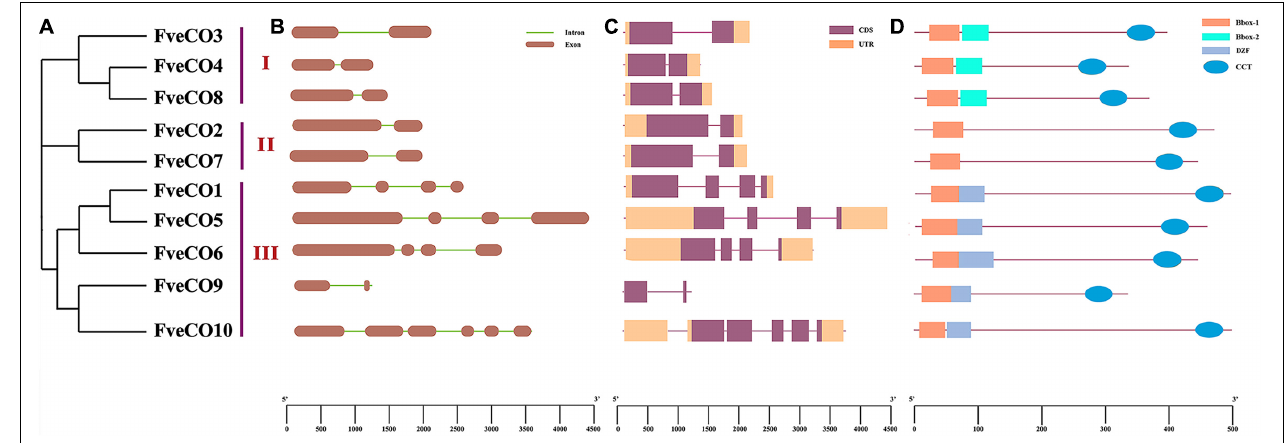
FIGURE 3 | Genomic and protein structures of FveCOs . (A) Phylogenetic analysis of 10 FveCO genes which are categorized them into three groups. (B) The intron distribution. The exons and introns are represented by dark ochre boxes and light green lines, respectively. (C) The CDS and UTR are represented by purple boxes and orange boxes, respectively. (D) The domain distribution of FveCOs. The CCT, B-box1, B-box2, and DZF are represented by light blue ovals, orange boxes, light green boxes, and blue–gray boxes, respectively.